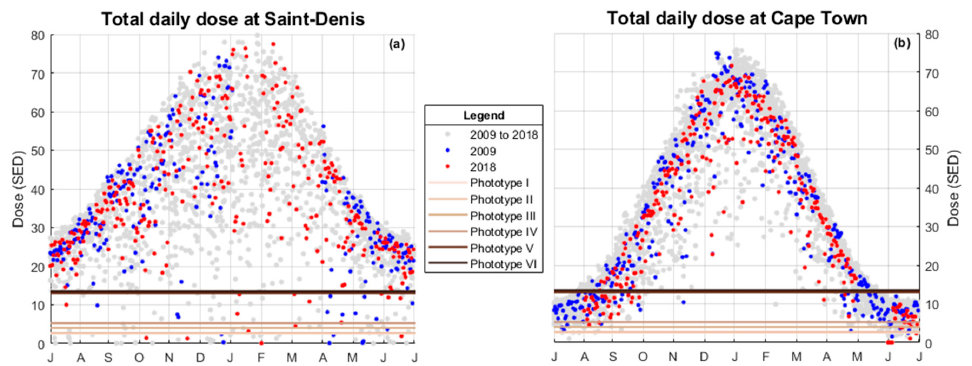
Figure 5. Total daily erythemal doses at Saint-Denis ( a ) and Cape Town ( b ). The grey dots represent all daily values recorded from 2009 to 2018. The blue and red dots highlight data from 2009 and 2018, respectively. The horizontal lines show the threshold for one dose to sunburn (Table 1) as a function of skin phototype. Months on the X-axis have been reorganized to highlight the austral summer, which appears in the middle of the plot.